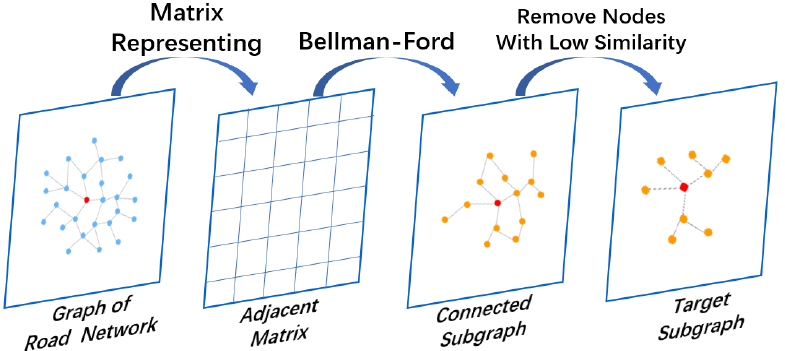
Figure 2. The process of the adaptive subgraph